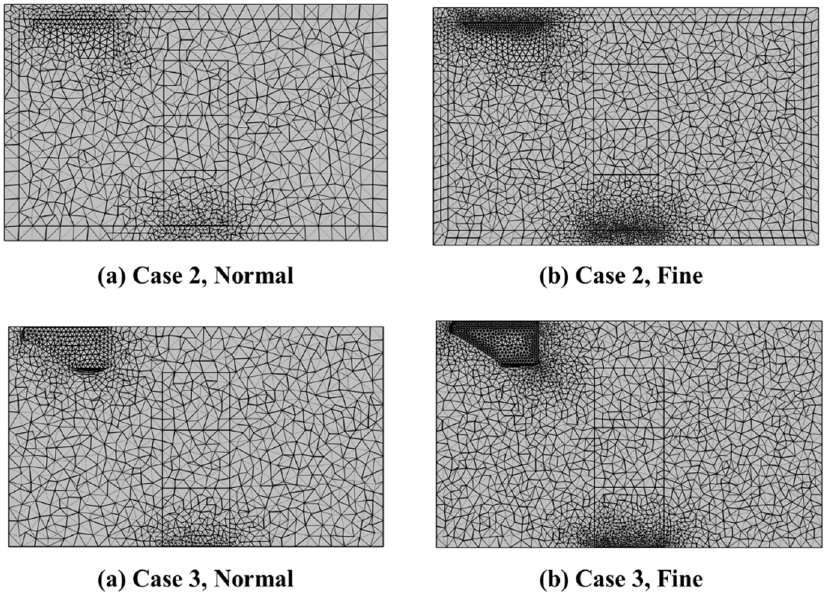
Figure 8. Two-element sized mesh grid for case 2 and case 3.